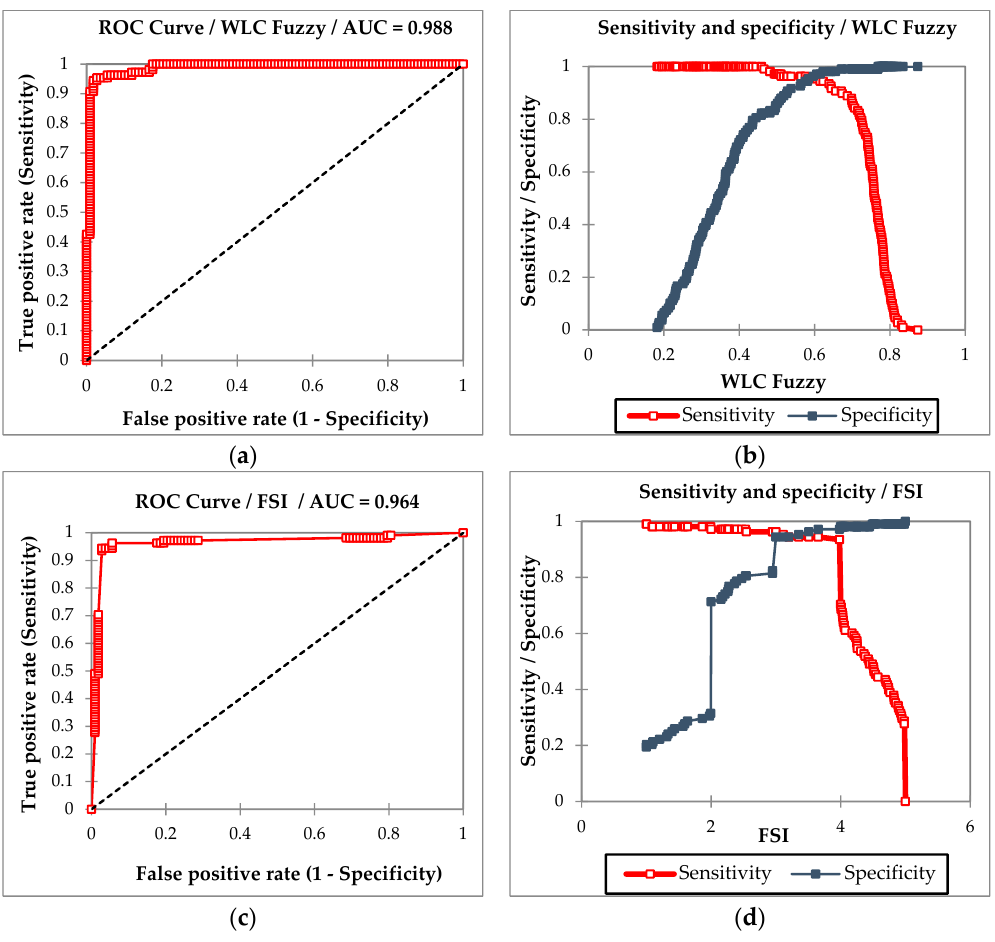
Figure 9. ROC curves (a, c) and diagrams of the specificity/sensitivity (b, d) for the WLC fuzzy and FSI methods.